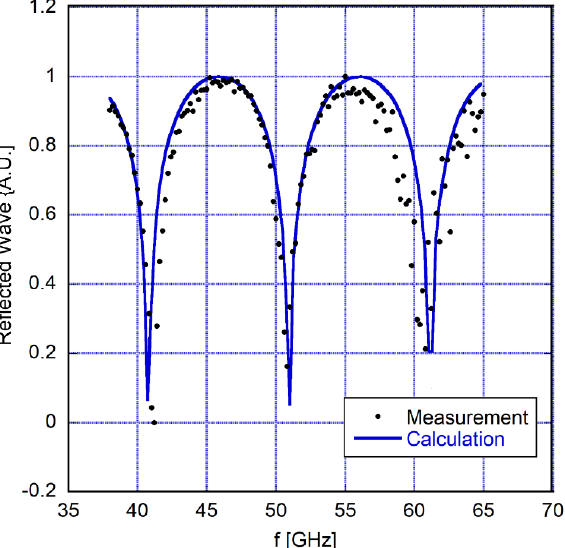
Figure 2. Measurement of reflected wave vs. frequency and numerical calculation of Fabry–Perot interferometry.